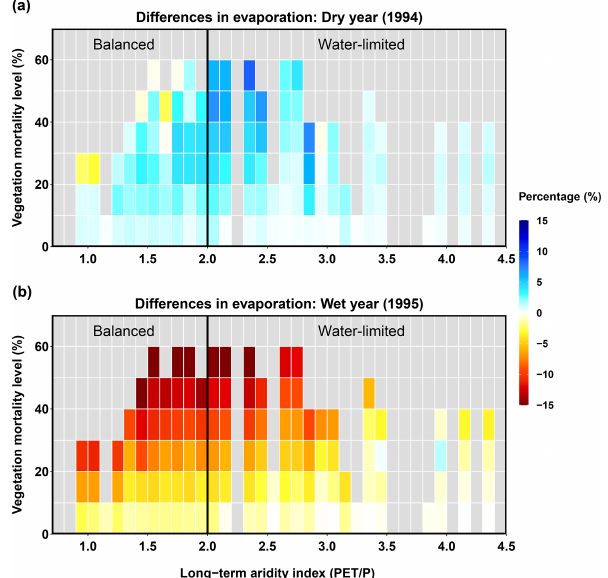
Figure 9. Relationships between long-term aridity, vegetation mor- tality level, and difference in ET for a dry year (1994, a ) and a wet year (1995, b